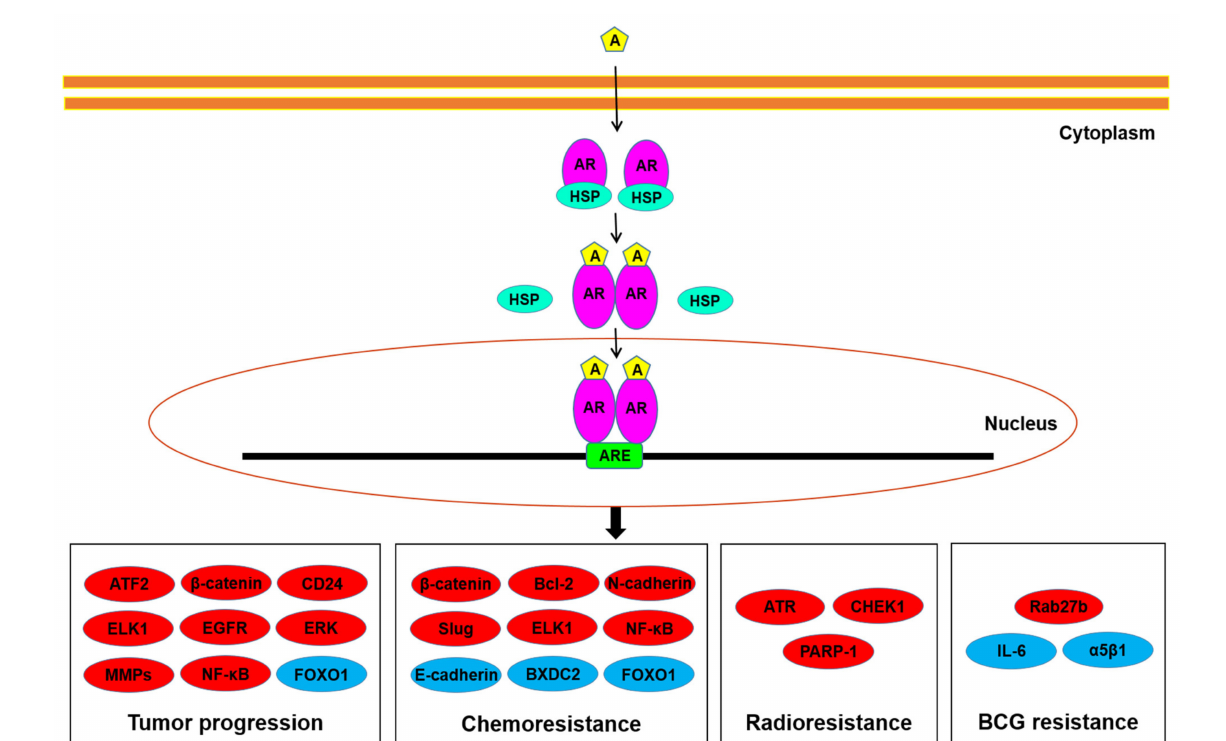
Figure 1. AR signaling in bladder cancer cells. Androgens have been suggested to induce tumor progression, as well as resistance to conventional non-surgical therapy, through the AR pathway via up-regulating (red) or down-regulating (blue) the molecules listed. A, androgen; ARE, androgen response element; HSP, heat shock